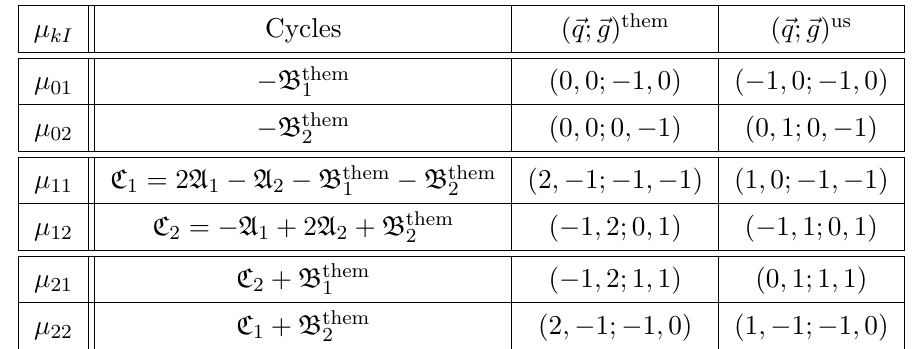
Table 1. The six stable BPS particles in the strong-coupling chamber of SU(3) gauge theory, together with the corresponding cycles and charges in the conventions of [35], as well as the translation of the charges into our